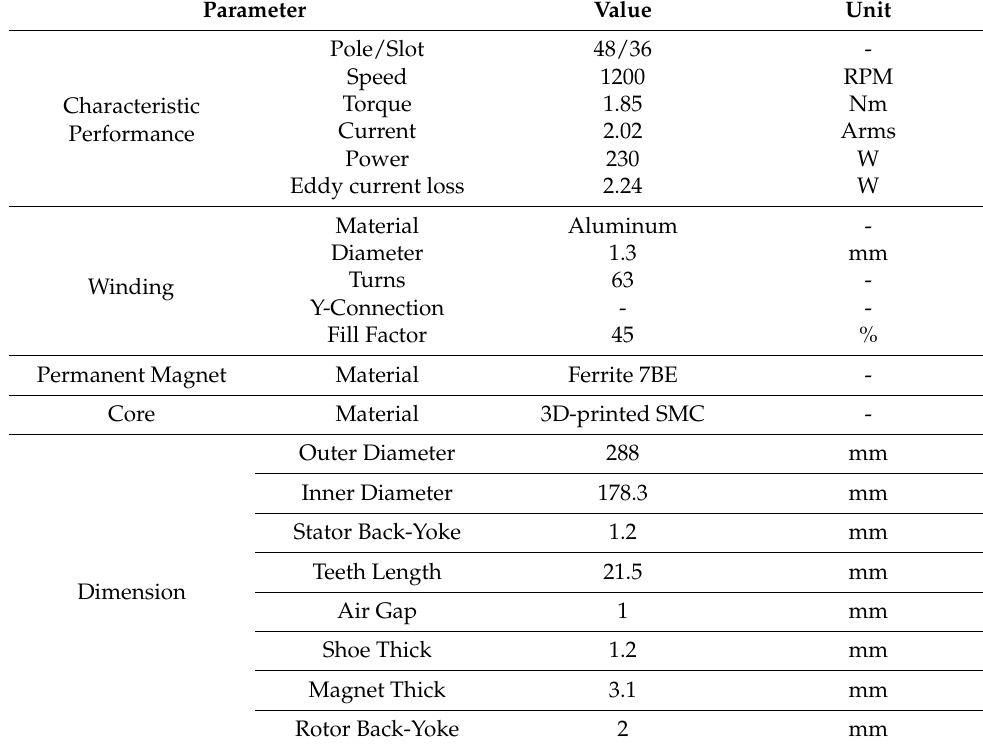
Table 1. Specification of conventional AFPMSM.